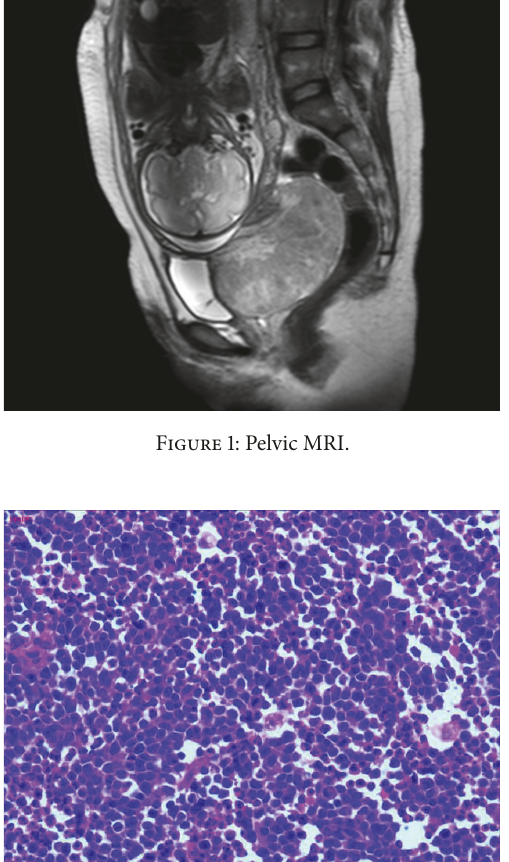
Figure 4: X400, CD56,